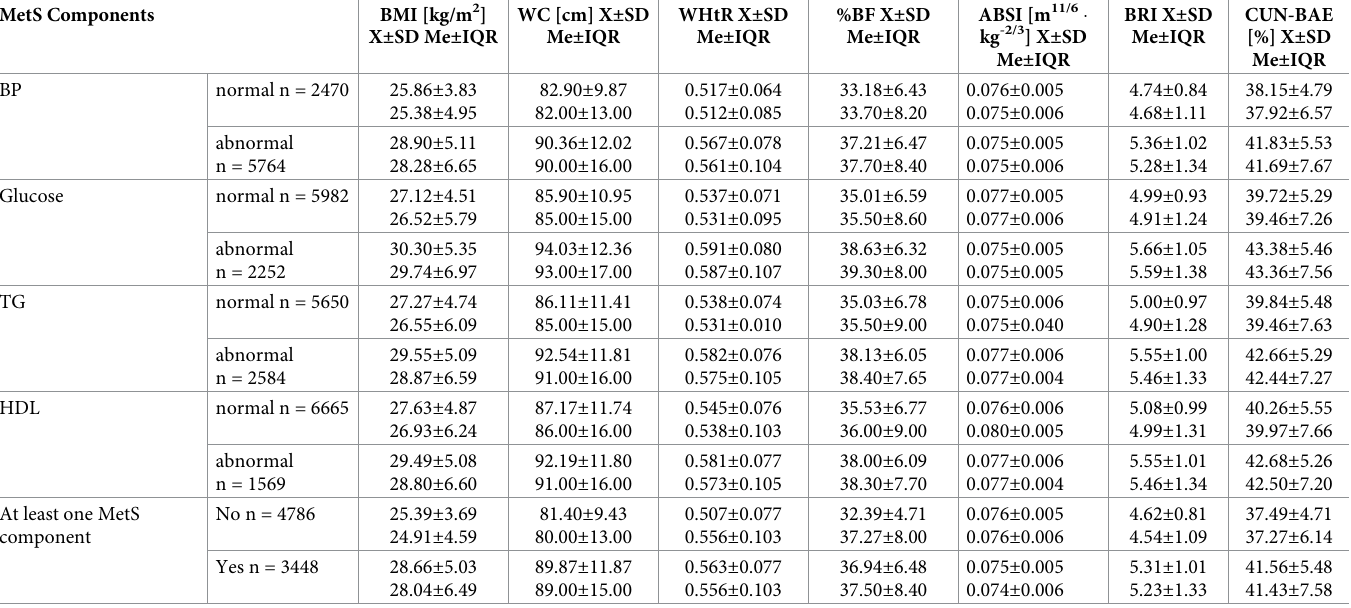
Table 2. Baseline anthropometric and laboratory characteristics of women (N =